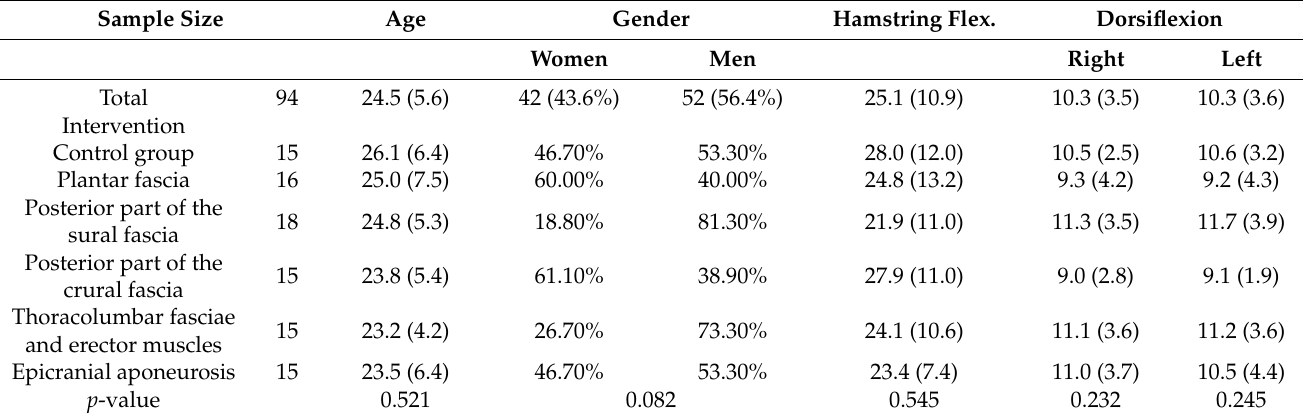
Table 1. Baseline characteristics of the participants grouped and compared by their intervention. Mean (standard deviation) for the quantitative variables; Frequency (percentage) for the qualitative variables; ANOVA test for the quantitative variables; Chi-square for the qualitative variables.